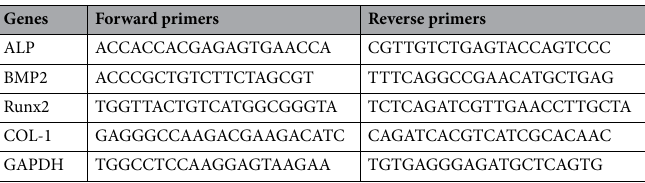
Table 3. The primer sequences of RT-PCR